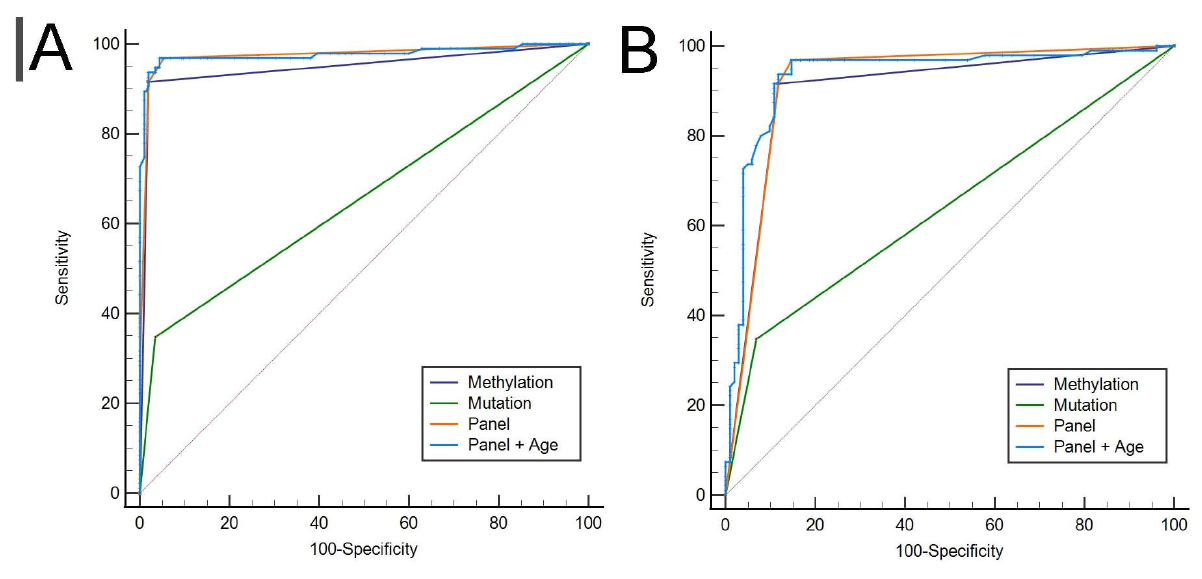
Figure 4. ROC curve of the of NRN1 methylation (AUC = 0.948), gene mutation (AUC = 0.657) and the panel (AUC = 0.975) in UTUC vs. begin disease ( A ) and of NRN1 methylation (AUC = 0.899), gene mutation (AUC = 0.639) and the panel (AUC = 0.920) in UTUC vs. other malignant tumors ( B ), respectively.